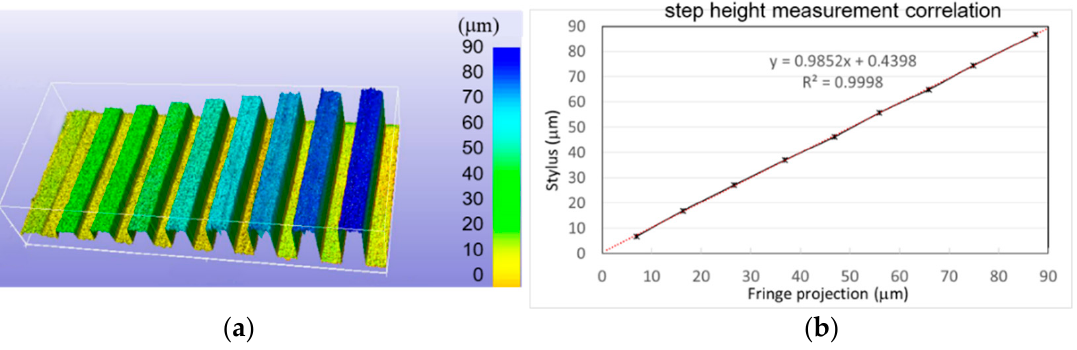
Figure 6. ( a ) Measurement of reference step heights with the fringe projection system. ( b ) Comparison of fringe projection system measurement results with certified values (nominal step heights: 5, 15, 25, 35, 45, 55, 65, 75, and 85 μ m).